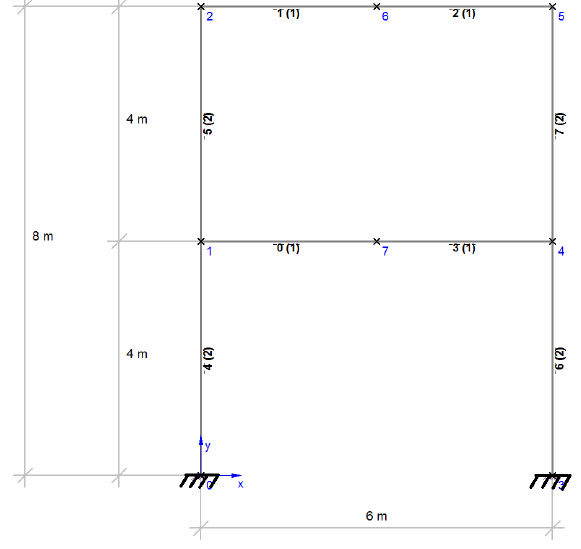
Figure 1. 2D-Model of the construction.